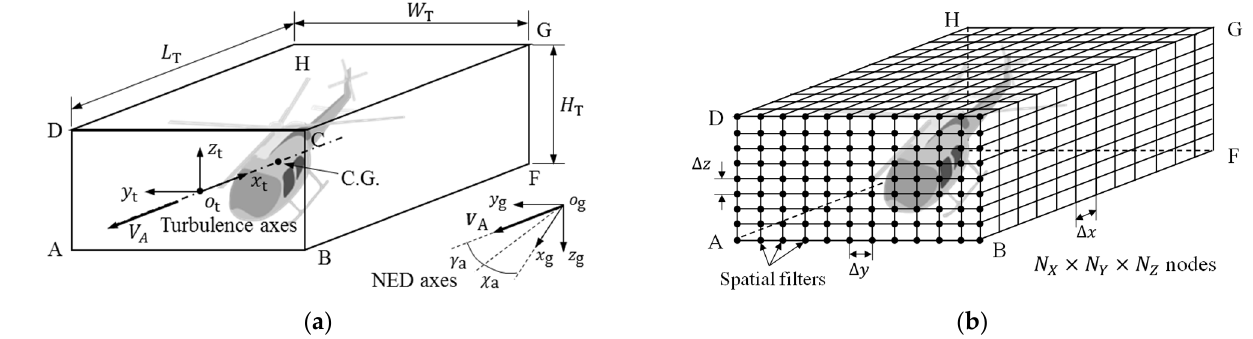
Figure 1. Moving spatial turbulence field. ( a ) Geometry; ( b ) Grid.